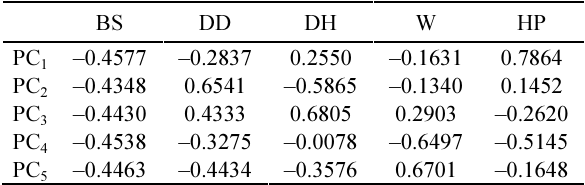
Table 3. Eigenvector of correlation